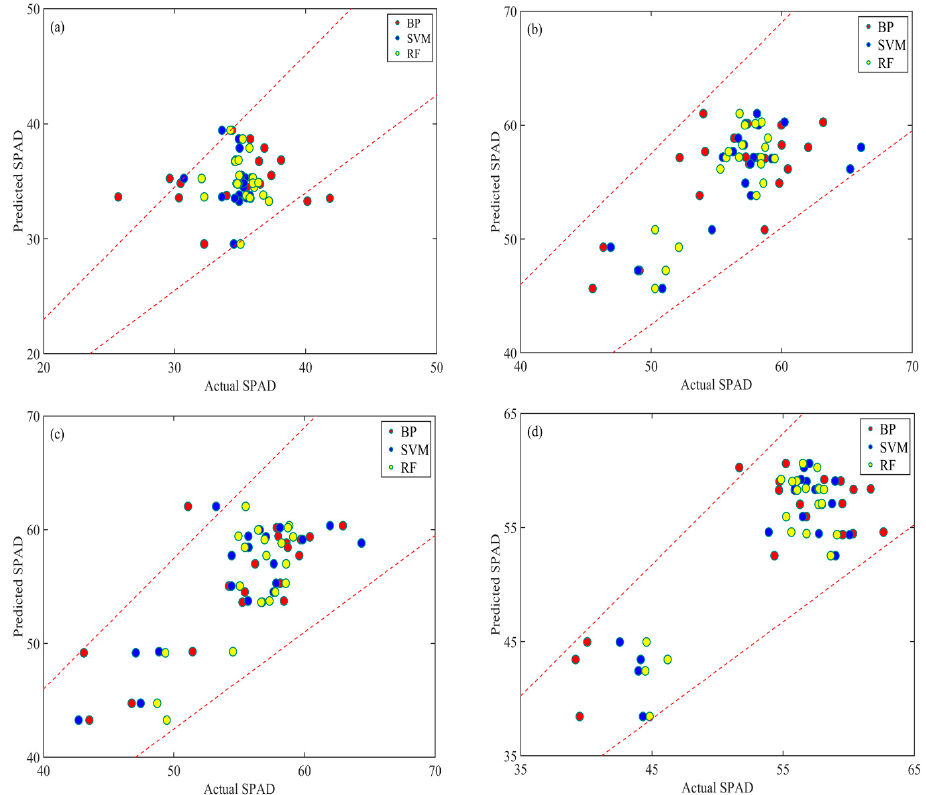
Figure 3. Chlorophyll contents predictions using ML methods. The red, blue, and yellow points are the predicted values of the chlorophyll contents using BP, SVM, and RF, respectively. ( a – d ) represents